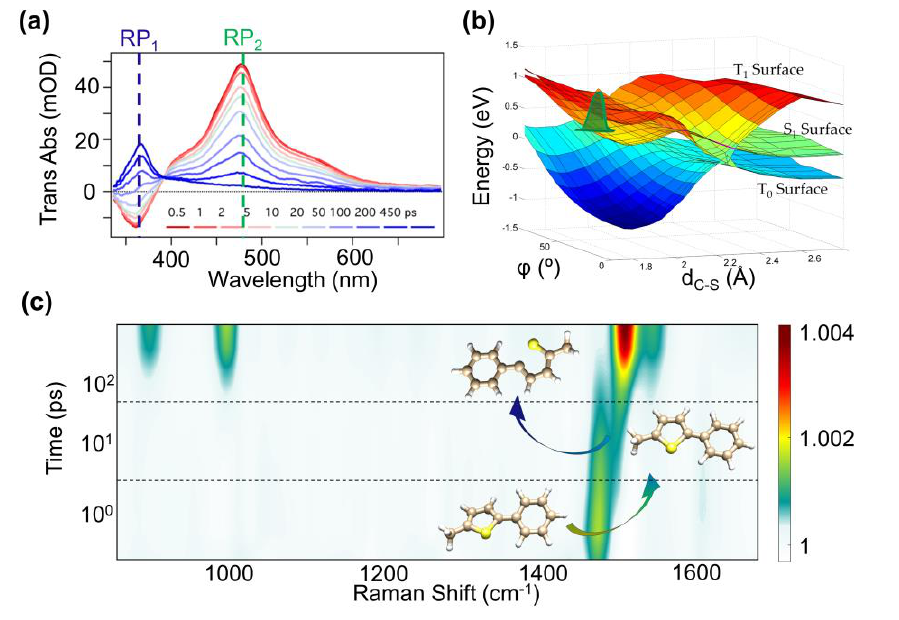
Fig. 1. (a) Transient absorption spectrum of MPT following a 266 nm excitation to the S 1 potential energy surface. The dashed lines indicate the Raman pulse wavelengths used in the FSRS experiments. (b) MPT excited potential energy surfaces computed by TD-DFT with B3LYP functional and the 6-31+g** basis set along the reaction coordinates φ and d C-S . (c) FSRS spectrum of MPT upon photo-excitation. After an ultrafast planarization and cooling of the system promoted on the excited S 1 state, the slow opening of the thiophene ring triggers an intersystem crossing to the triplet